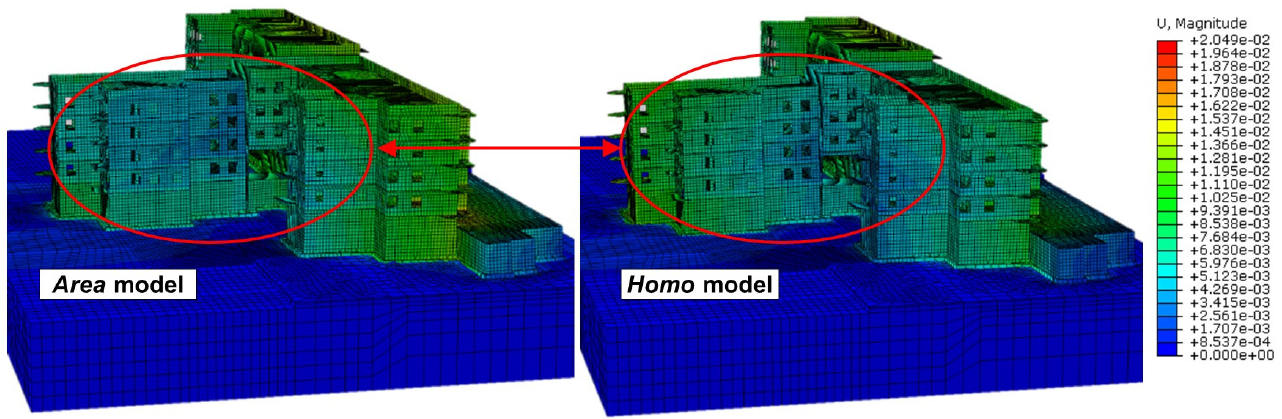
Figure 20. A comparison of maps of resultant displacements [m] of the building in the AREA ( left ) and HOMO ( right ) models.